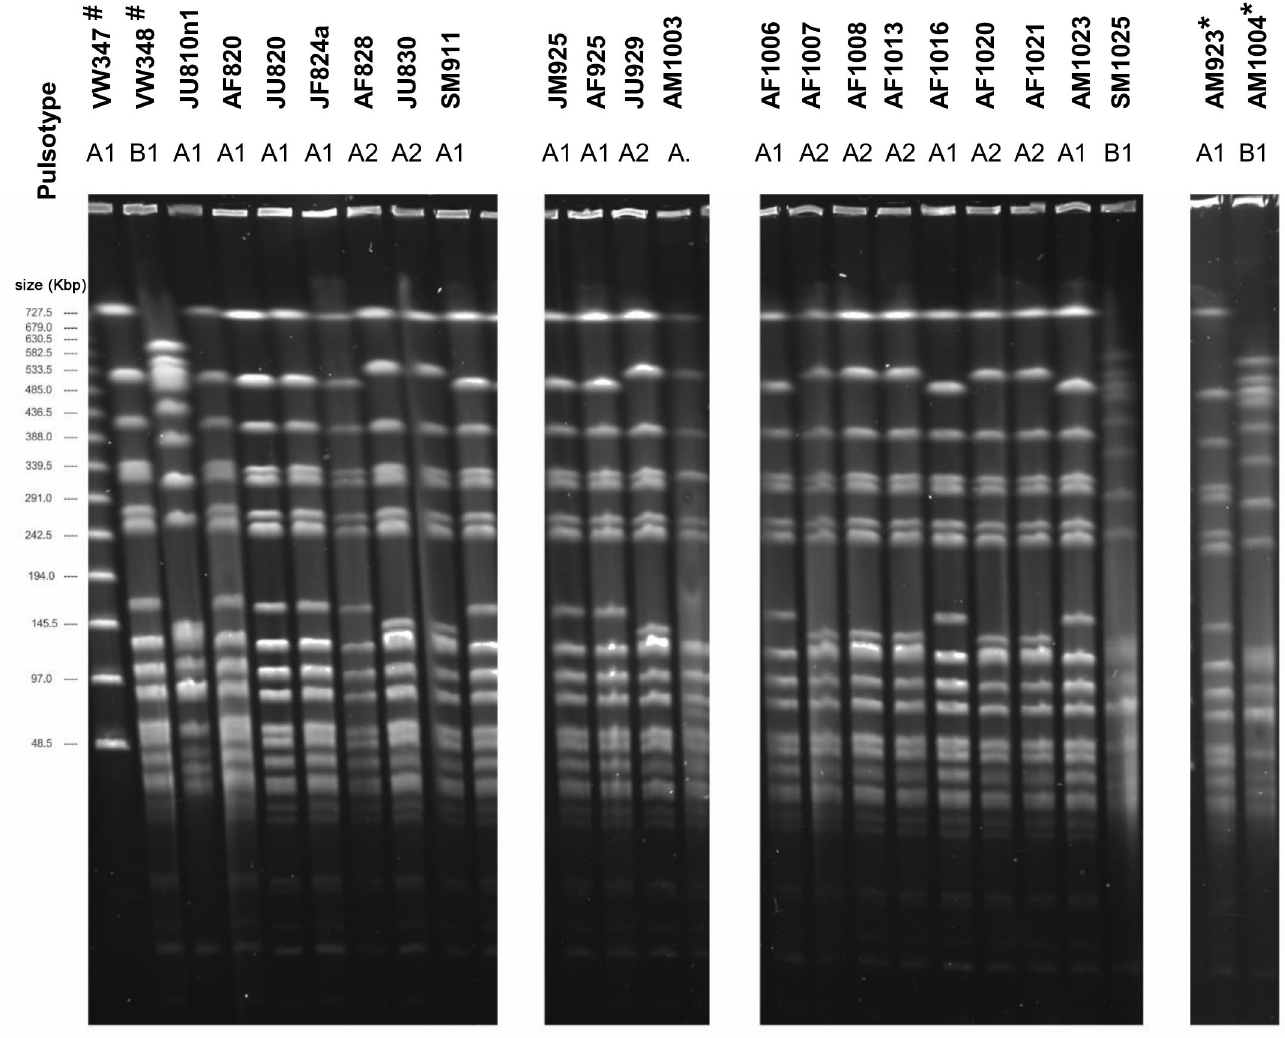
Fig 1. Pulsed field gel electrophoresis analysis of Serratia spp. isolated from haemolymph of captive D . australis between August and October 2014. # Isolates (VW347 and VW348) from insects collected prior to this study and provided by Zoos Victoria. � Strains representative of the pulsotypes A and B and selected for complete genome sequencing. Molecular weight marker: lambda PFG ladder (New England Biolabs).